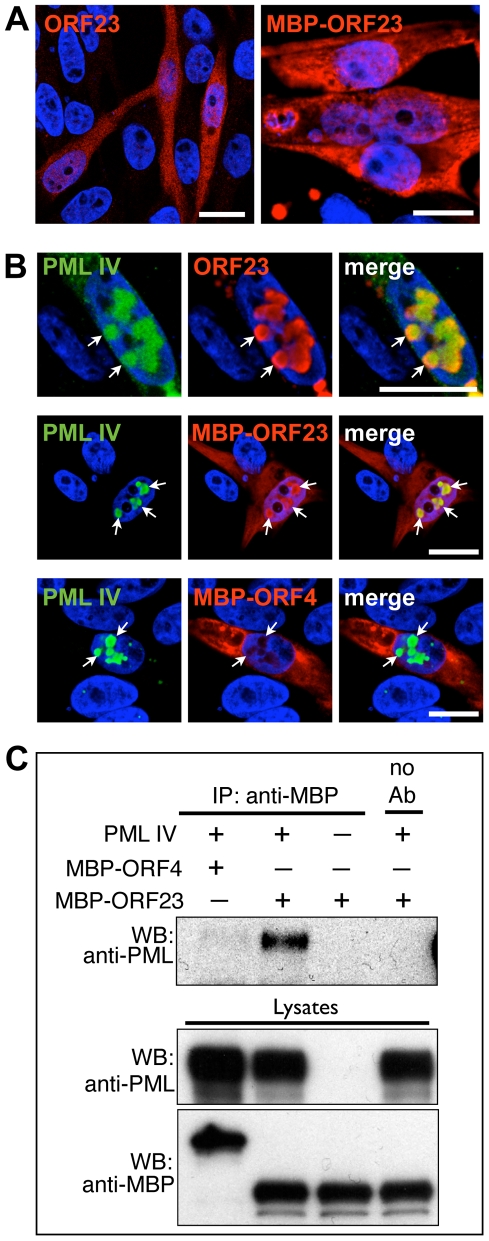
PML IV binds ORF23 capsid protein in the absence of other viral proteins.(A) Representative IF images show the cellular distribution of either untagged ORF23 (red; left panel) or maltose binding protein (MBP)-tagged ORF23 (red; right panel) at 48 hr after transfection of melanoma cells. (B) IF localization of untagged ORF23 protein (red; upper panels), MBP-tagged ORF23 protein (red; middle panels) or MBP-tagged ORF4 protein (red; lower panels) and PML IV bodies (green, white arrows) at 48 hr after transfection of melanoma cells. Nuclei were stained with Hoechst (blue). All scale bars are 5 µm. (C) Coimmunoprecipitation (Co-IP) of PML IV using an anti-MBP polyclonal (rabbit) antibody in cells co-transfected with PML IV expression plasmid and MBP-ORF23 or the control MBP-ORF4, in the combinations as indicated by ‘+’ and ‘-’. Co-IP of mock-transfected cells (no PML IV overexpression) is shown in the lane at the far right. PML IV was identified by immunoblotting with a polyclonal (rabbit) anti-PML antibody. Western blot of the lysates confirmed the expression of transfected PML IV, MBP-ORF23 and MBP-ORF4 (lower panel).